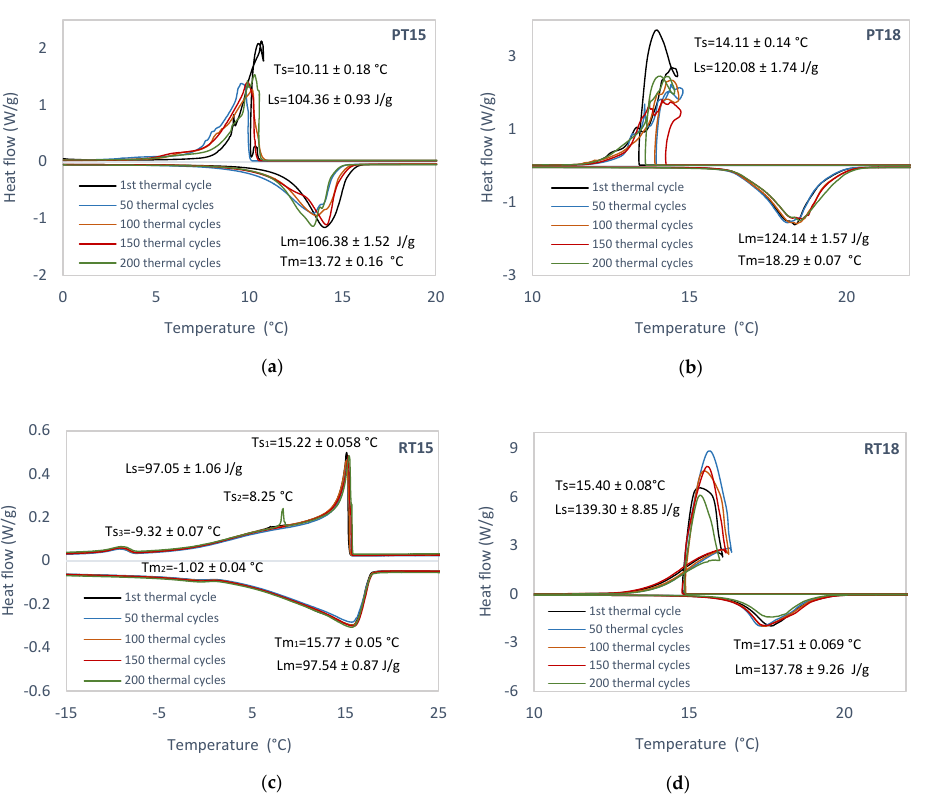
Figure 2. DSC thermogram of ( a ) PT15, ( b ) PT18, ( c ) RT15, ( d ) RT18 in 1st, 50, 100, 150, 200 thermal cycles. Obtained melting/solidification temperatures and enthalpies are shown.